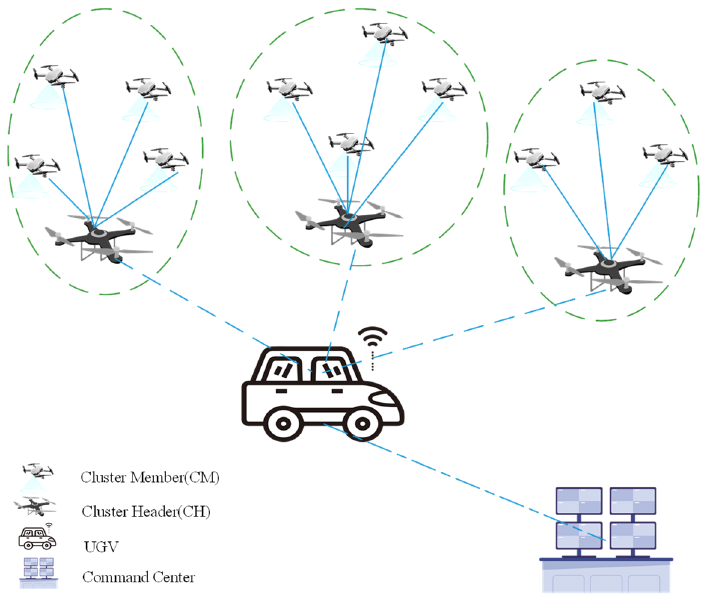
Figure 1. Network architecture based on ground-air cooperation in border patrol scenarios.